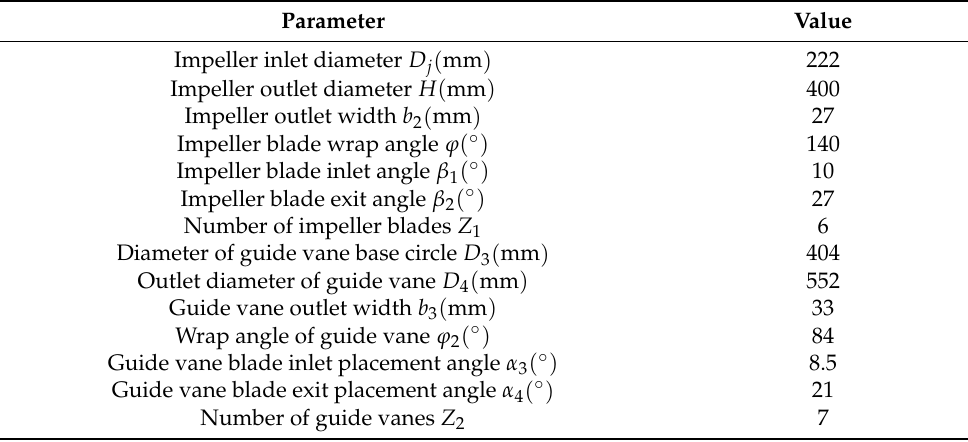
Figure 3. Calculation domain. Table 1. Geometry parameters of the guide vane.